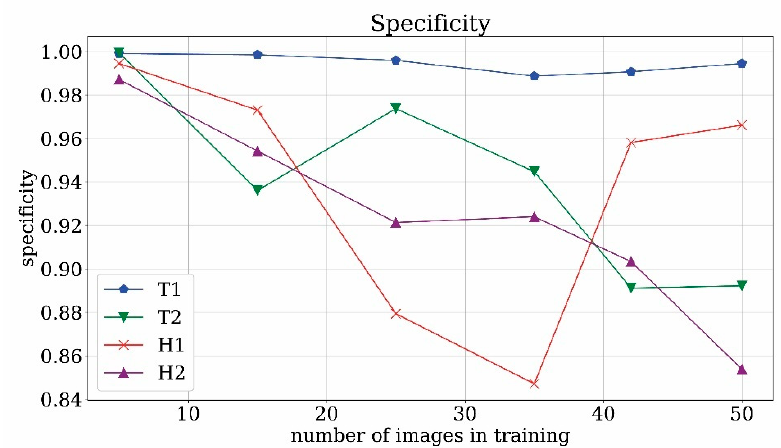
Figure 20. Sensitivity analysis evaluated on frames.